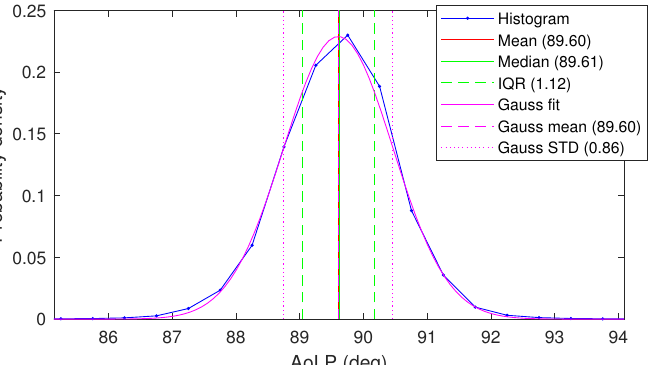
Figure 10. Histogram for the large ROI of Figure 9 with Gaussian fitting. Mean and median angles as well as inter-quartile range (IQR) and mean and standard deviation taken from the Gaussian fit parameters are